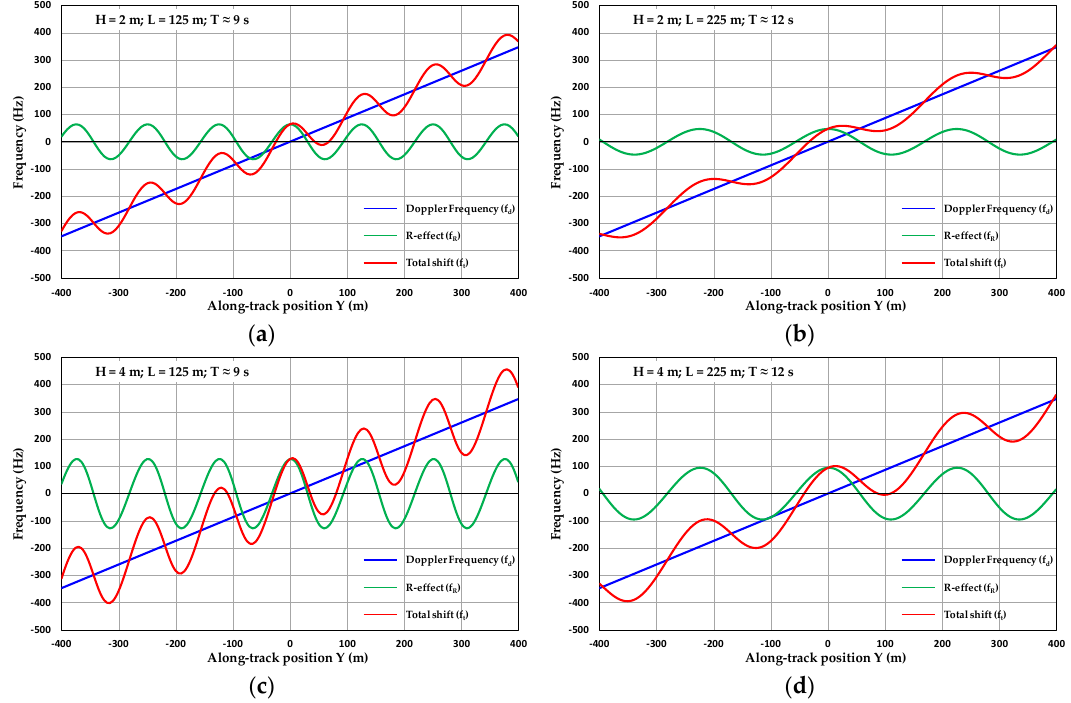
Figure 5. Along-track Doppler frequency shift values for different sinusoidal waves: ( a ) wave height H = 2 m, wavelength L = 125 m, wave period T ≈ 9 s; ( b ) H = 2 m, L = 225 m, T ≈ 12 s; ( c ) H = 4 m, L = 125 m, T ≈ 9 s; ( d ) H = 2, L = 225 m, T ≈ 12 s.